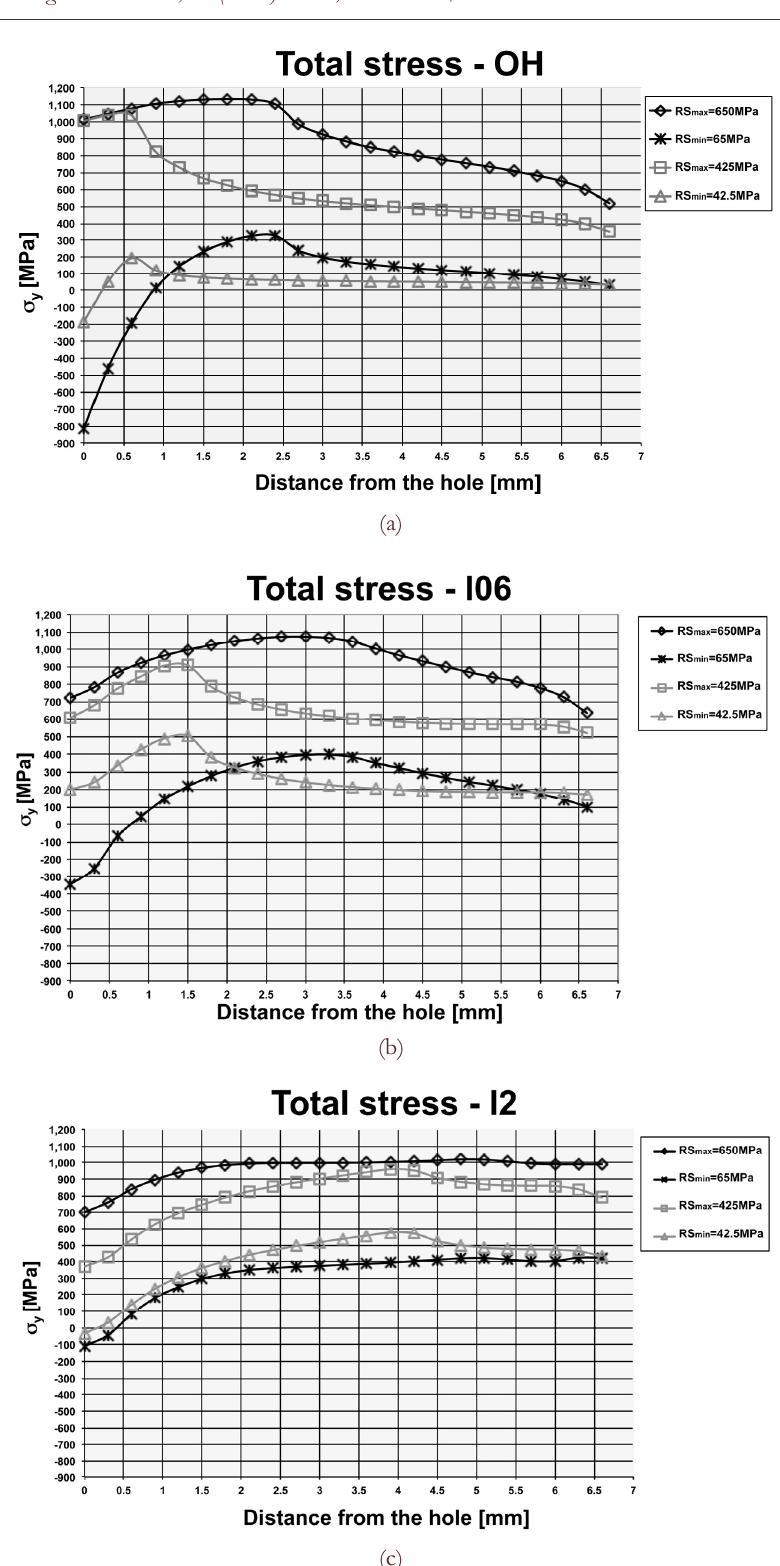
Figure 6: Axial stress amplitude diagrams (Total stress amplitude: a) OH; b) I06; c)